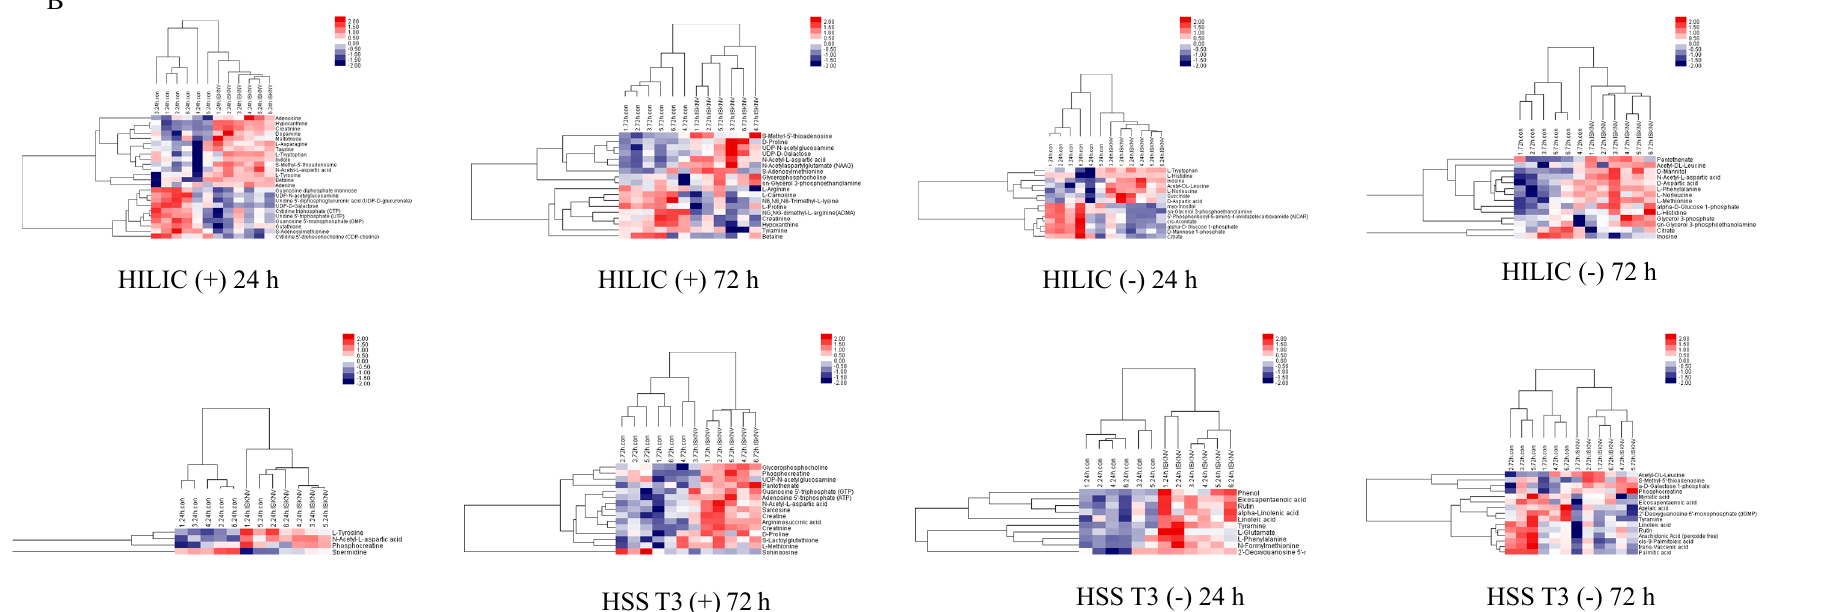
Figure 2. Analysis of differential metabolites in ISKNV-infected CPB cells. ( A ) PLS-DA plots based on the UHPLC-Q-TOF/MS data from the ISKNV groups vs. the control groups; ( B ) Heat map of clustering analysis of the ISKNV groups vs. the control groups.